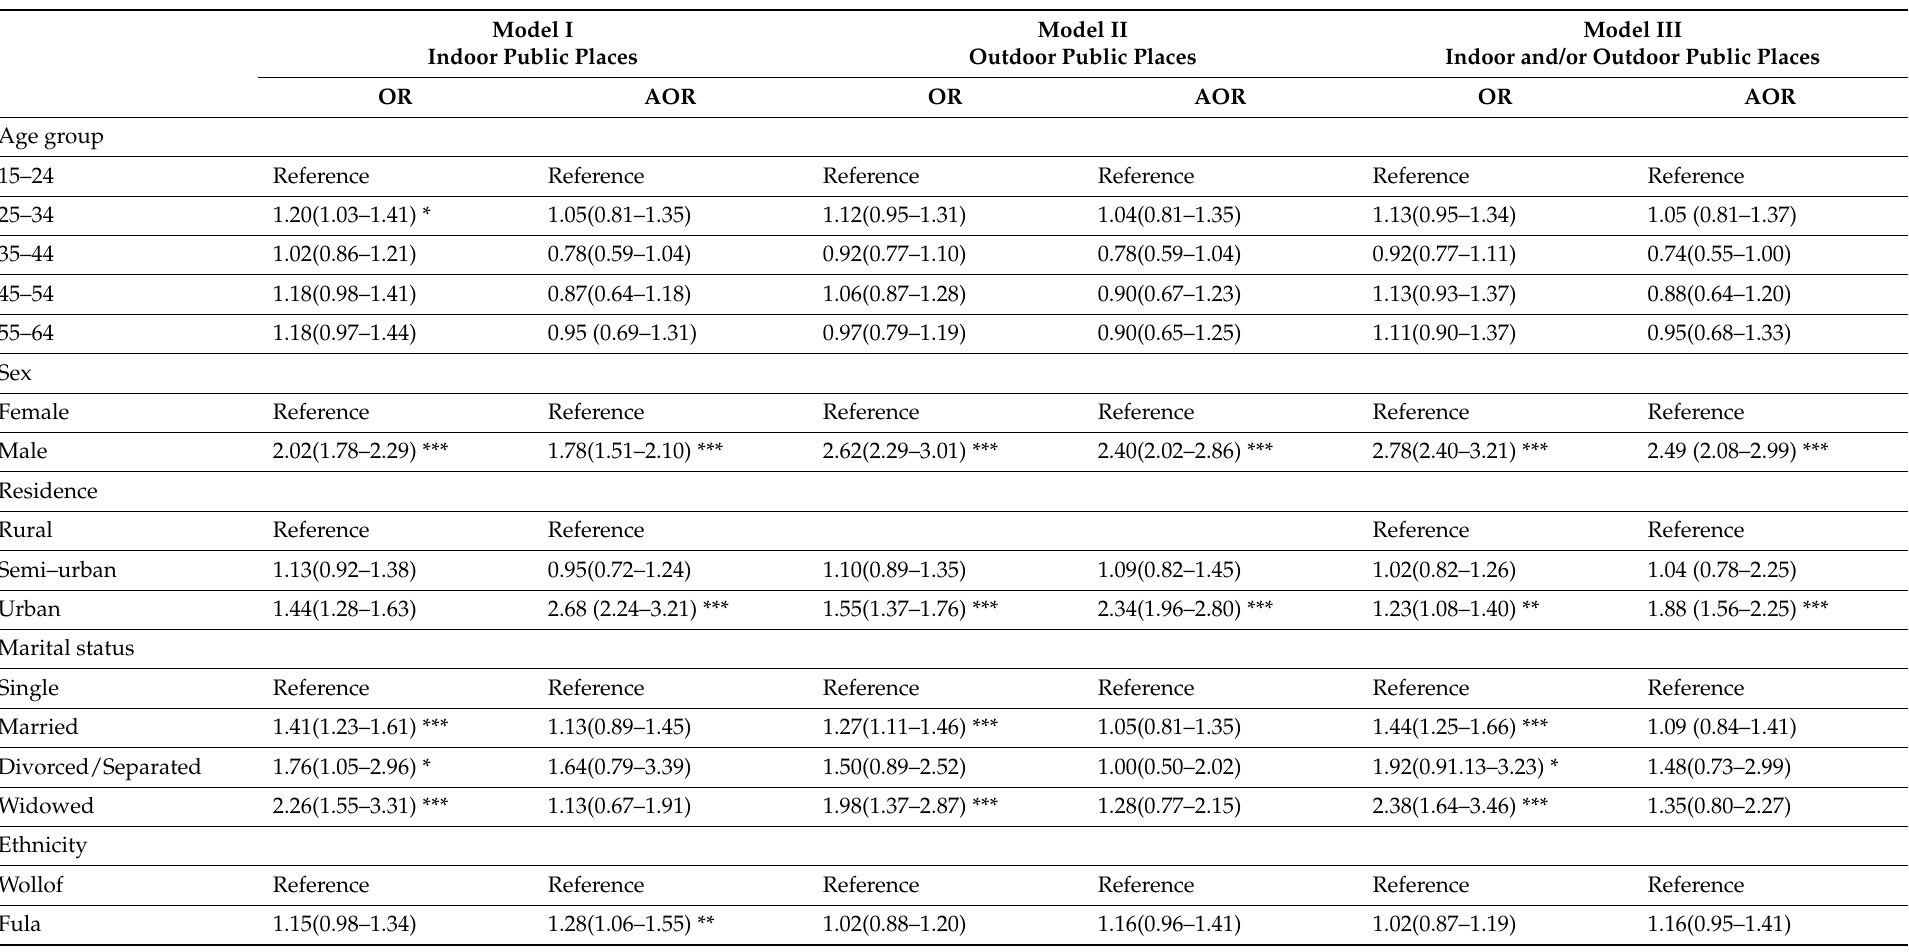
Table 2. Factors associated with exposure to second-hand smoke in public places ( n =